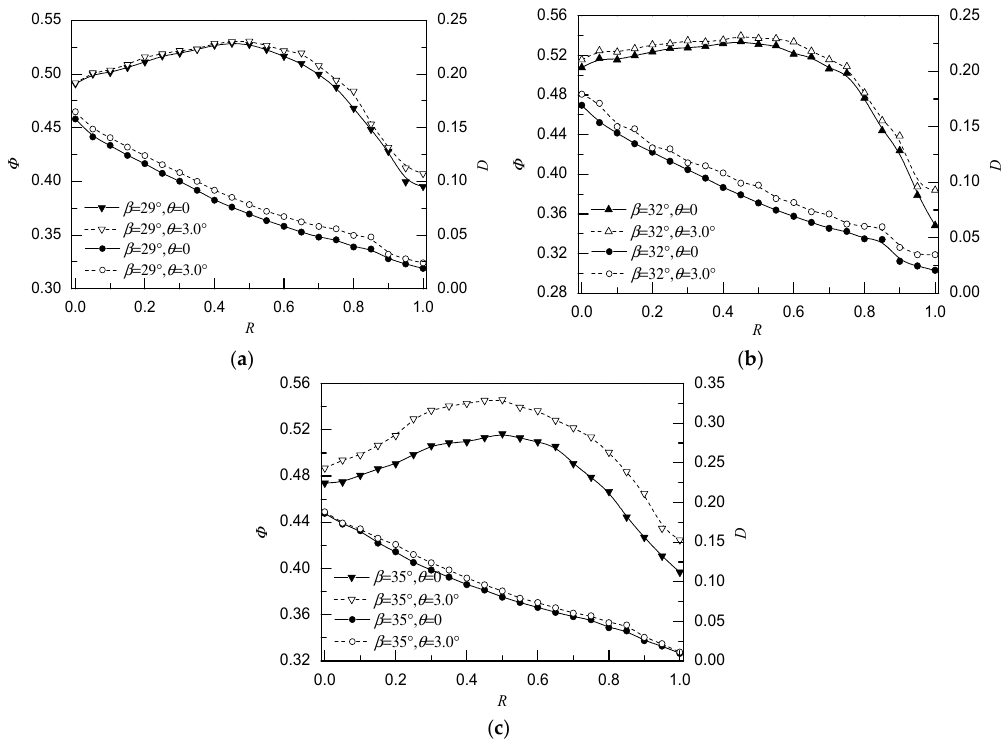
Figure 12. Distribution of total pressure rise and di ff usion coe ffi cient. ( a ) β = 29 ◦ ; ( b ) β = 32 ◦ ; ( c ) β = 35 ◦